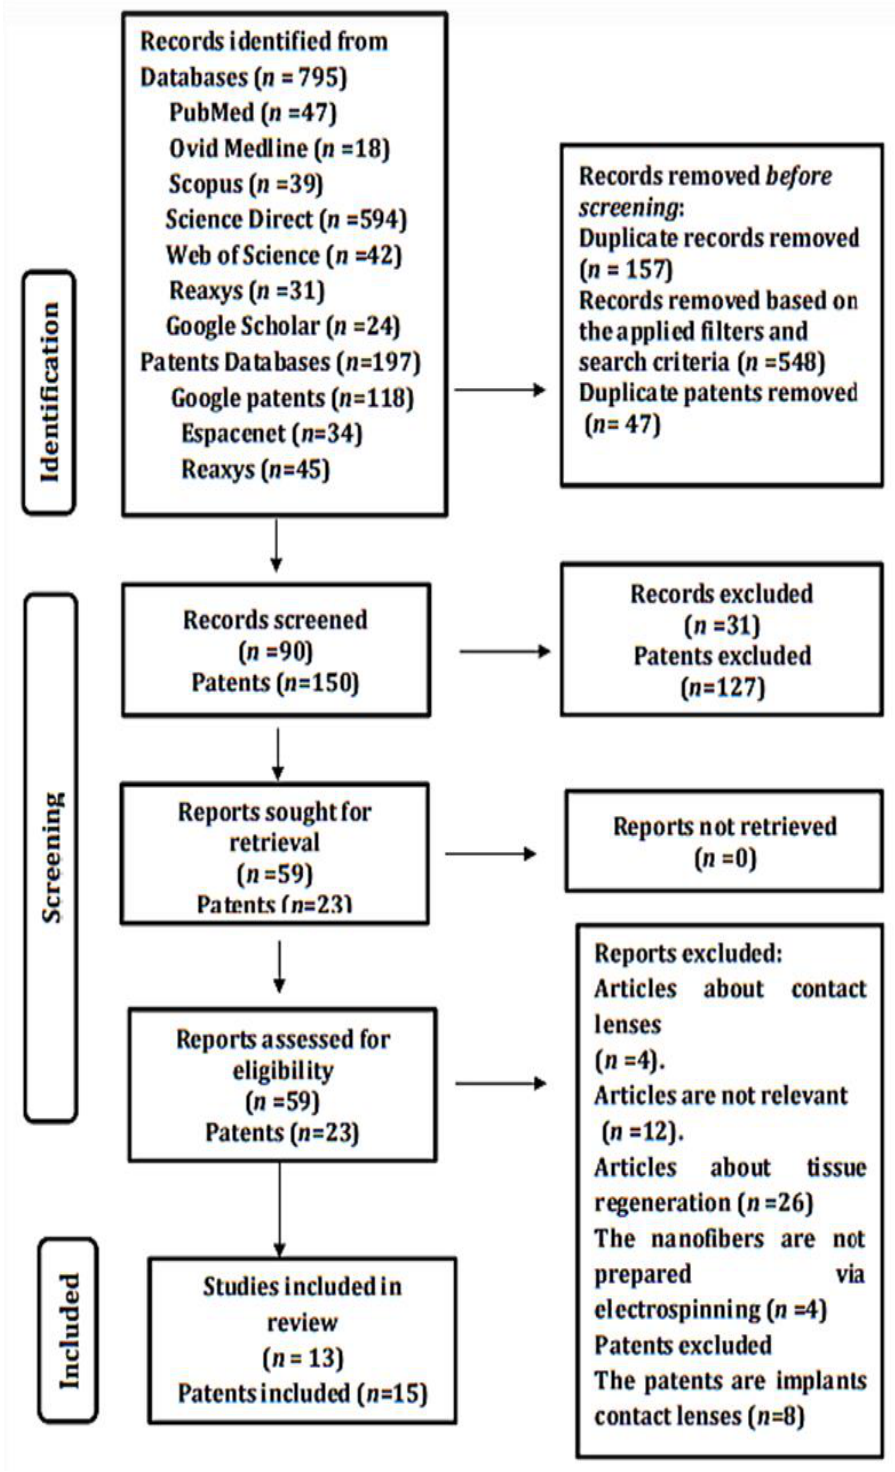
Figure 3. PRISMA-2020 flow diagram showing relevant articles and patents included in the